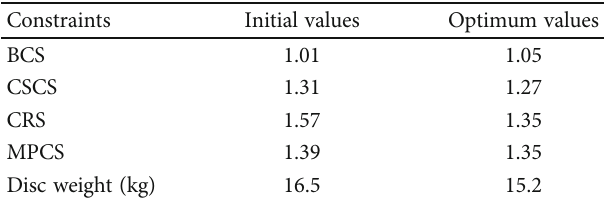
Table 4: Optimum